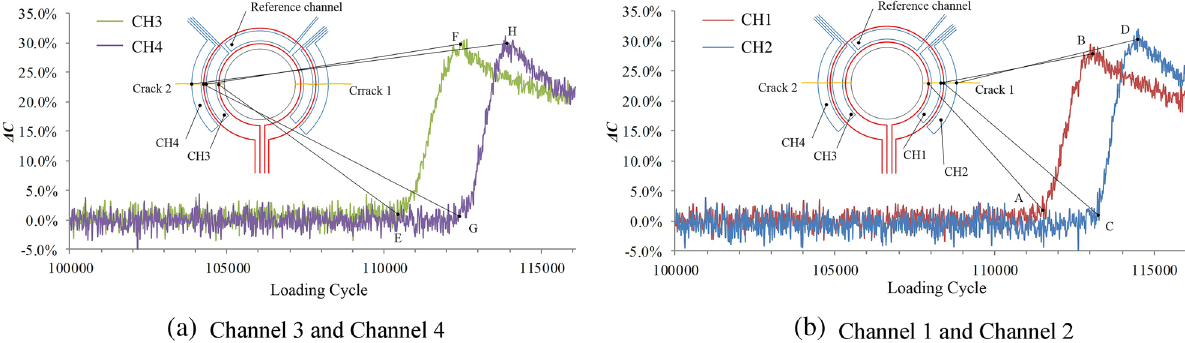
Figure 19. Relationship between sensor output signal and number of load cycles.